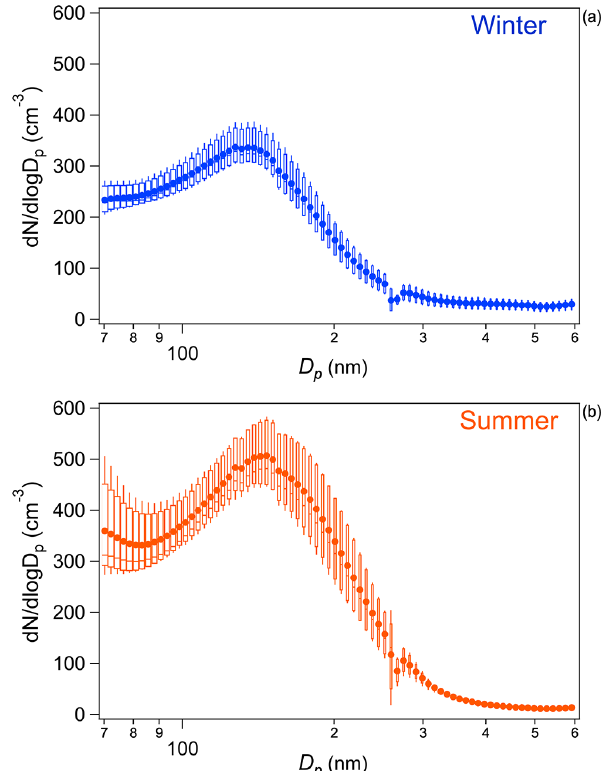
Figure 2. Particle size distribution in winter (a) and summer (b) in the ENA. The whiskers and boxes show the 90th, 75th, median, 25th, and 10th percentiles, and the circles represent the mean value per each size bean circle. Discontinuity is at around 270nm due to technical limitations of the UHSAS (handoff region between two internal gain